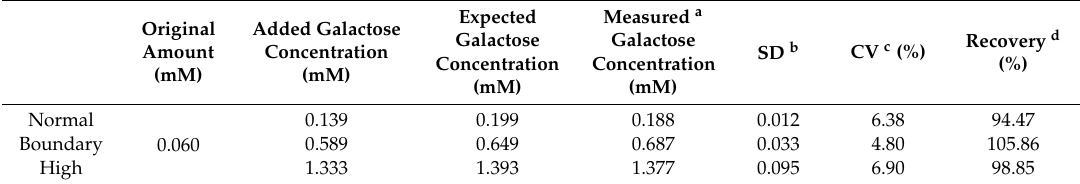
Table 1. Detection precision of the agarose_nanoceria_Gal Ox-based assay system for the determination of galactose levels in spiked human serum samples.